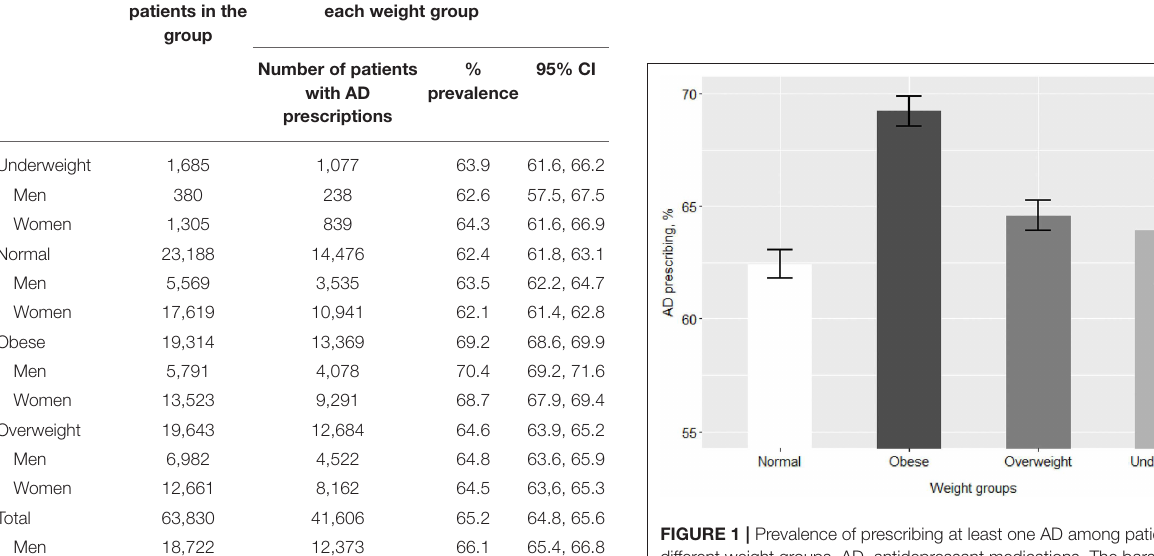
TABLE 2 | Prevalence of prescribing at least one AD to patients with depression, according to the weight category and sex. Weight group